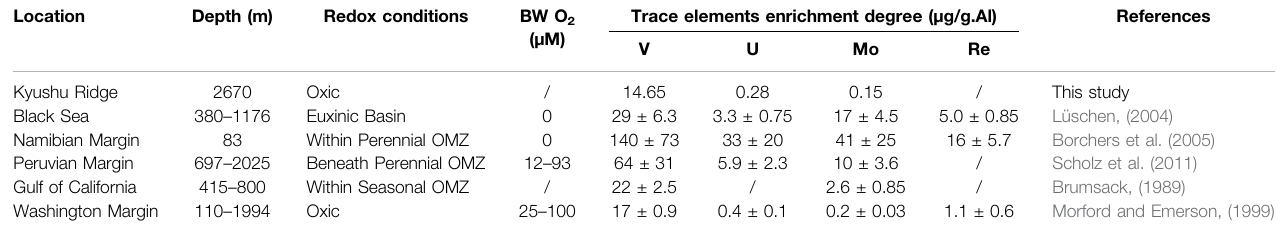
TABLE 3 | Comparison of RSEs enrichment in core St10-PC with well-known redox conditions. Location